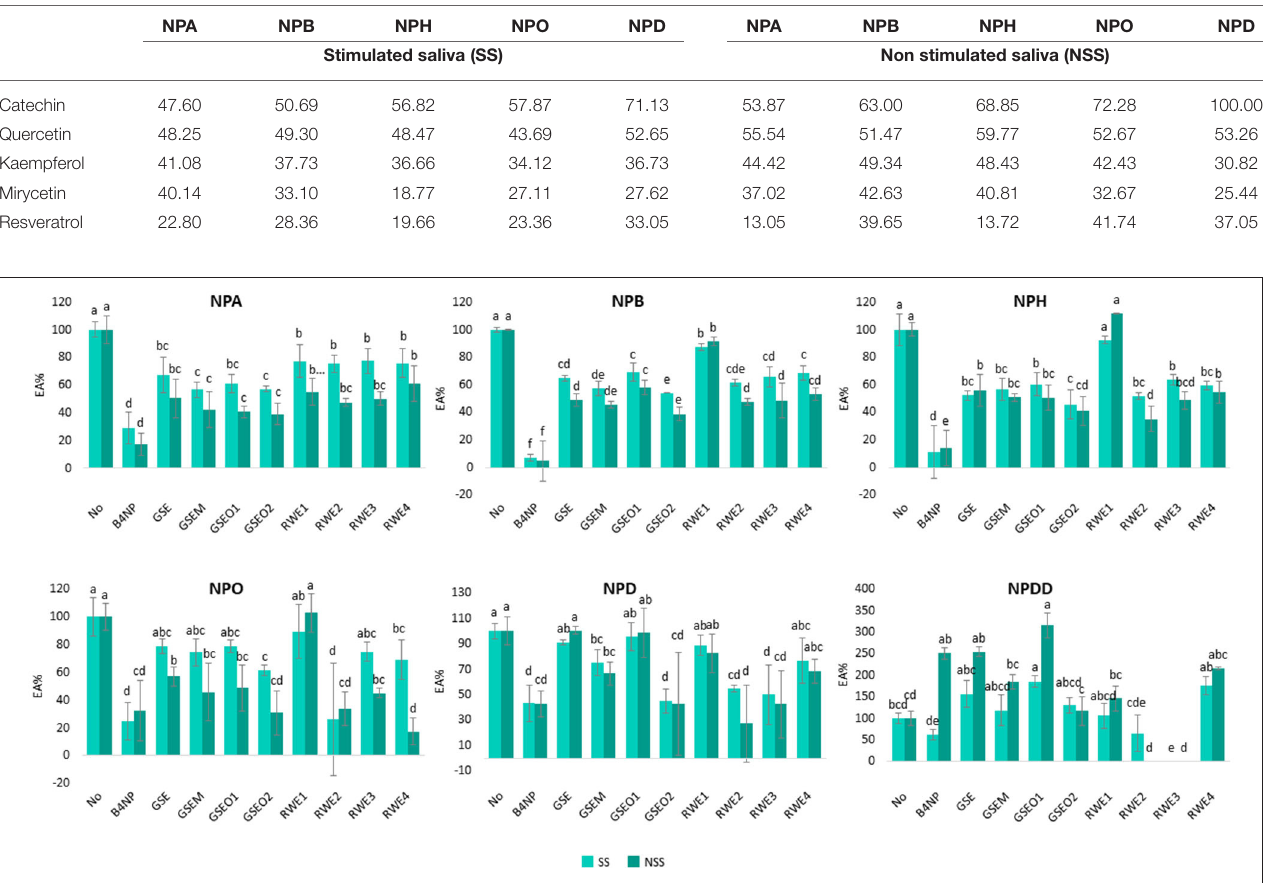
FIGURE 4 | Percentage of EA determined in SS and NSS toward six p-NP-esters with different carbon chain lengths (from C2 to C12) in the presence of four phenolic extracts (GSE, GSEM, GSEO, and RWE) added at different concentrations to the microplate well-depending on the maximum concentration of each of their phenolic components found in the red wines ( Table 2 ). Different letters above the bars mean significant differences ( p < 0.05) from Tukey’s